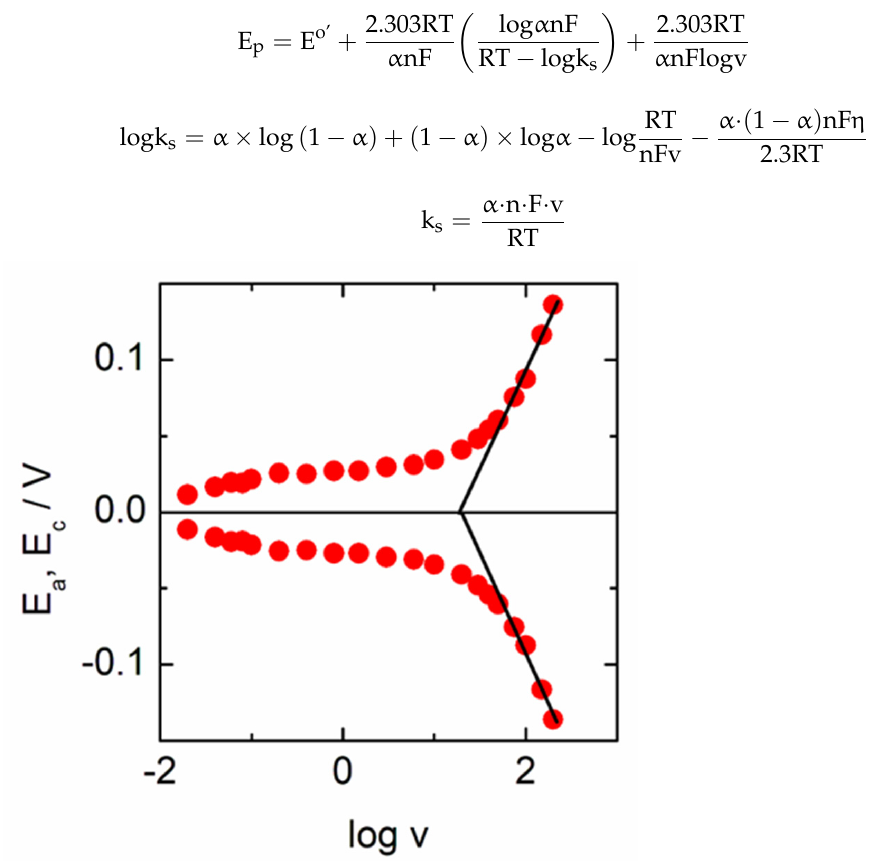
Figure 4. Plot of the cathodic and anodic peak potentials of the Hb-AuNTs as a function of the scan rate. Results are obtained from the voltammograms of Figure 2A.